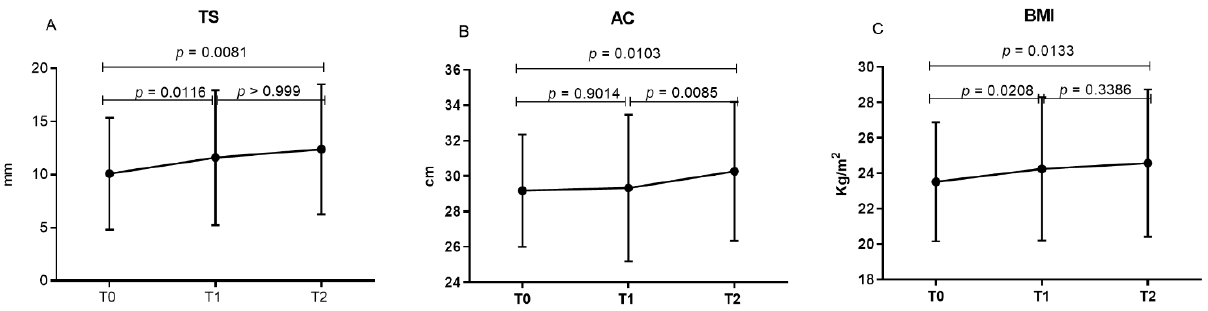
Figure 2. Comparison of the nutritional parameters ( A ) tricipital skinfold – TS, ( B ) arm circumference – AC and ( C ) body mass index – BMI of individuals with HIV1 between the periods evaluated. T0: initial assessment, before starting ART; T1: evaluation after 12 months of ART; T2: evaluation after 24 months of